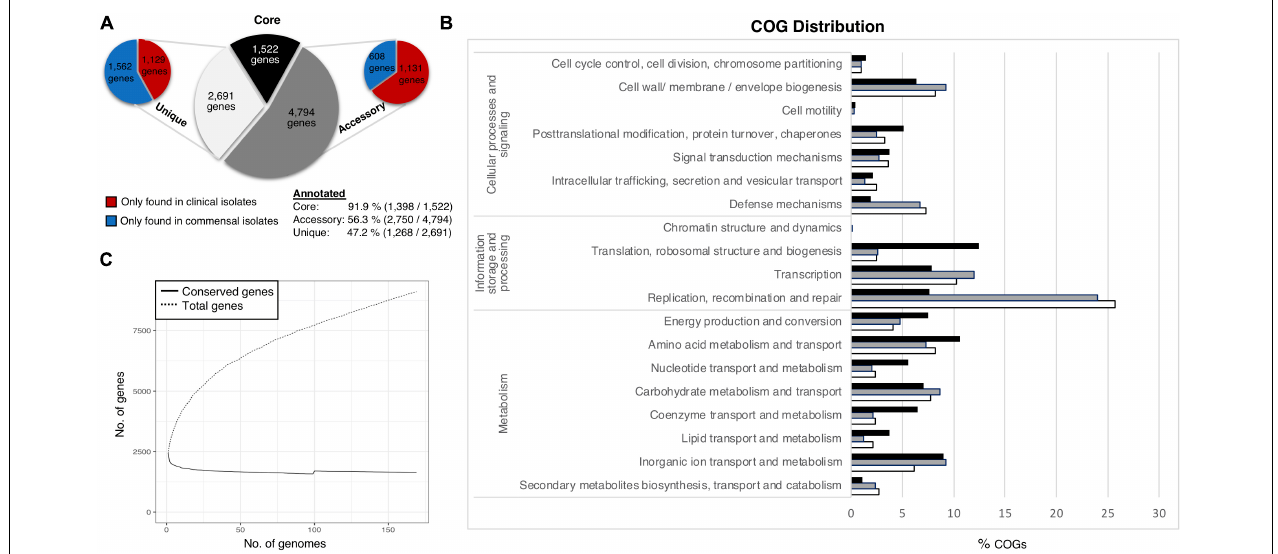
FIGURE 1 | Staphylococcus haemolyticus pangenome statistics. (A) The size and distribution of the pangenome into the subgroups; core (shared by all isolates), accessory (shared by some isolates) and unique (found only in one isolate). (B) Collective distribution of core (black), accessory (gray) and unique (white) genes in COG. (C) Pangenome curve generated by plotting total number of gene families in the pan and core